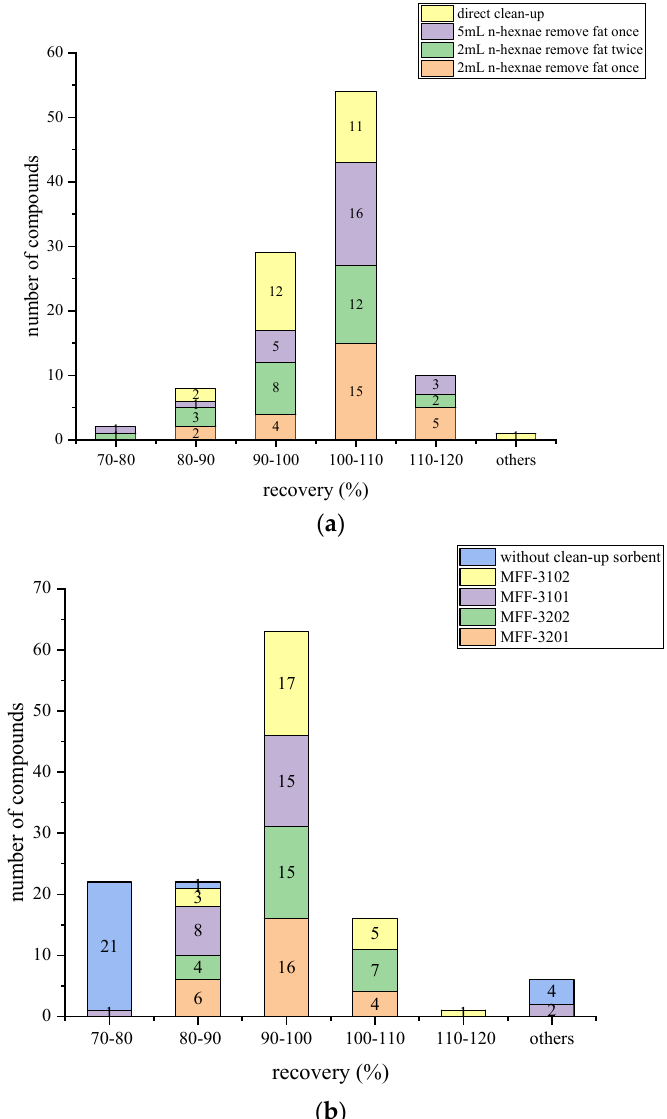
Figure 3. Comparison of the number of compounds with various recoveries using different fat removal methods ( a ) and purification materials ( b